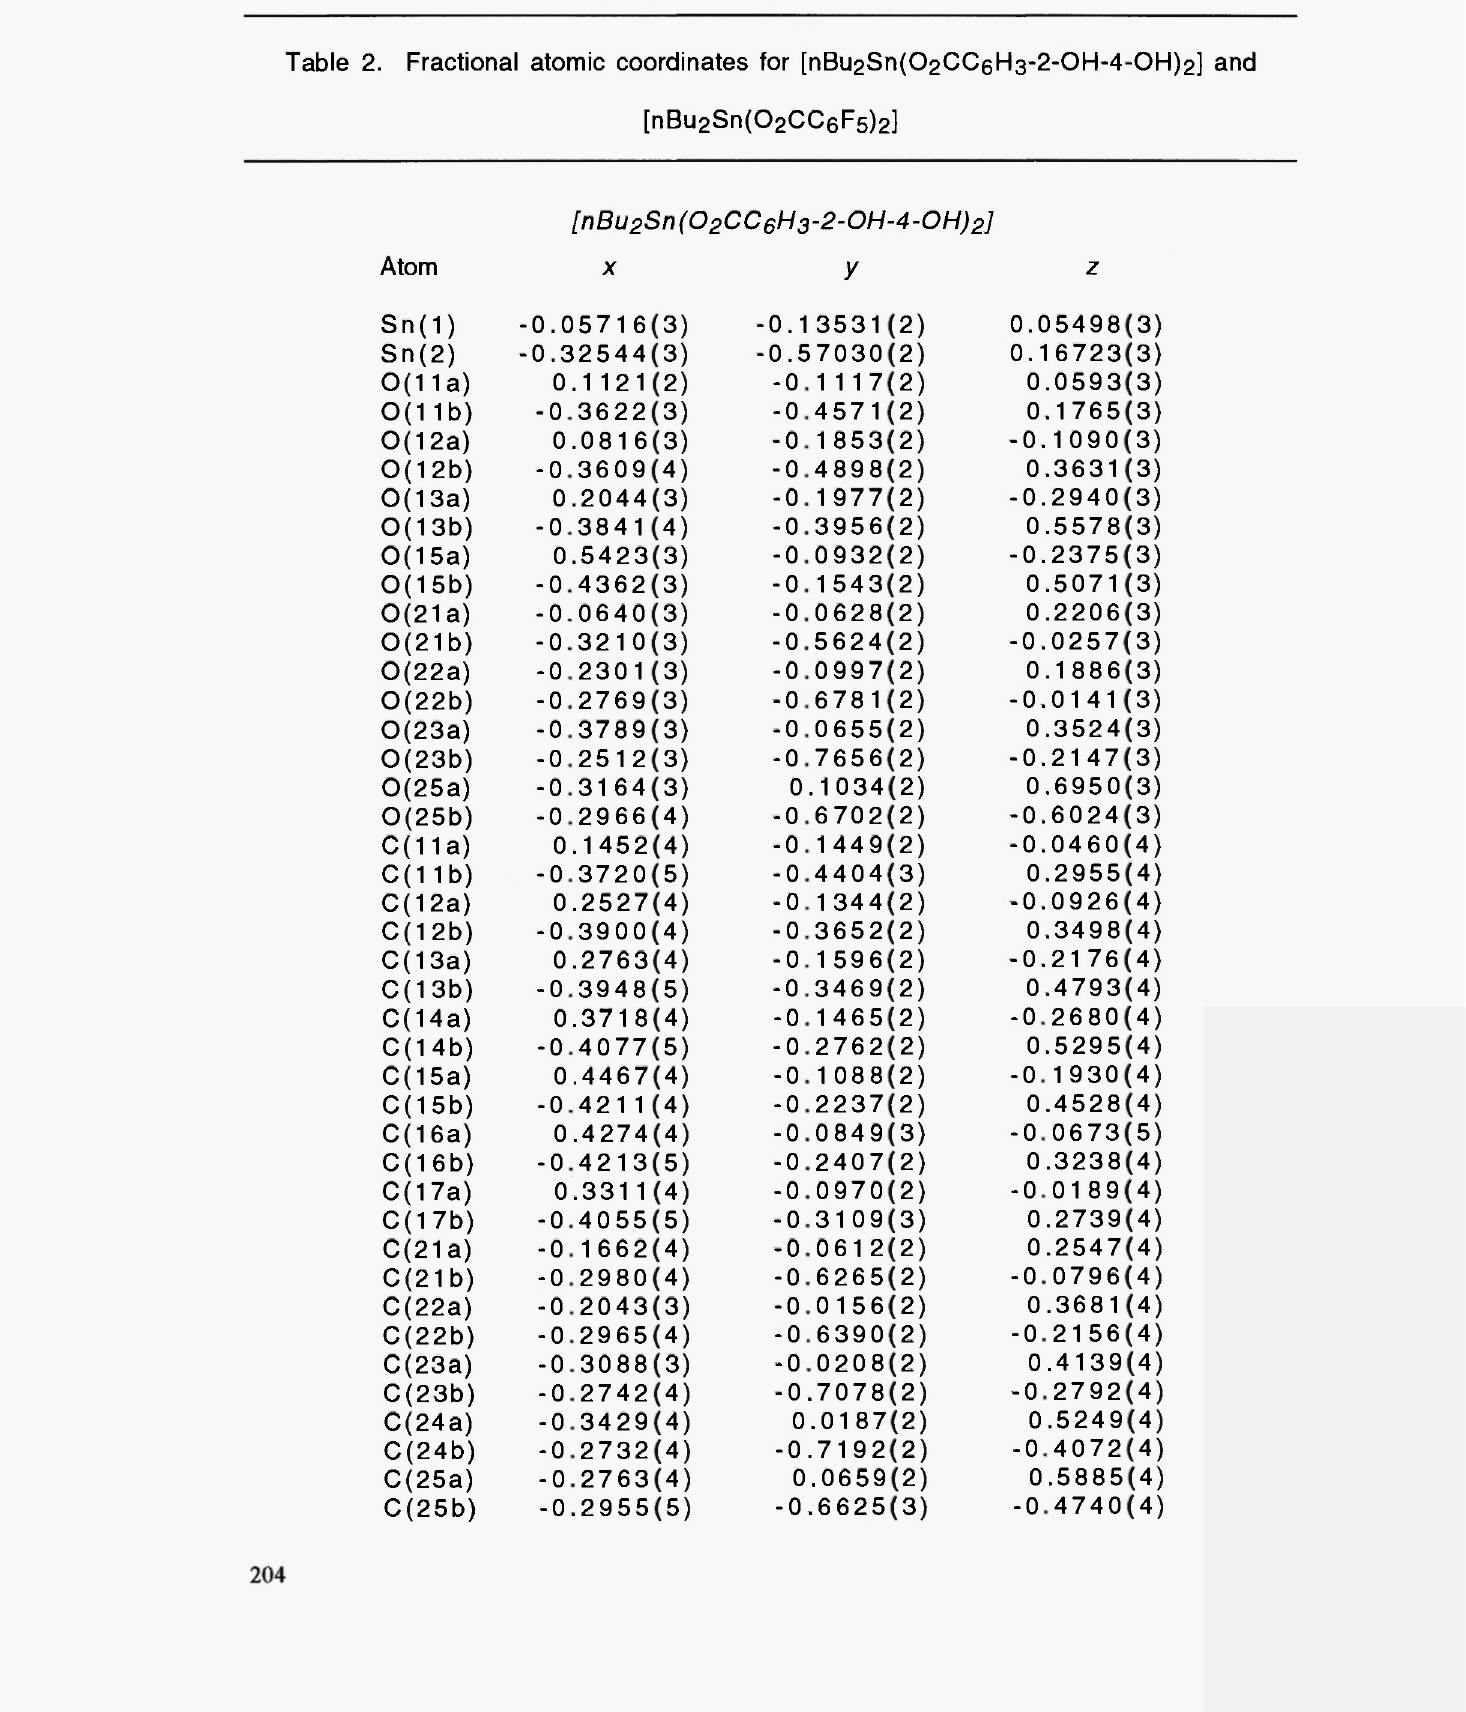
Fractional atomic coordinates for [nBu2Sn(02CC6H3-2-0H-4-0H)2]